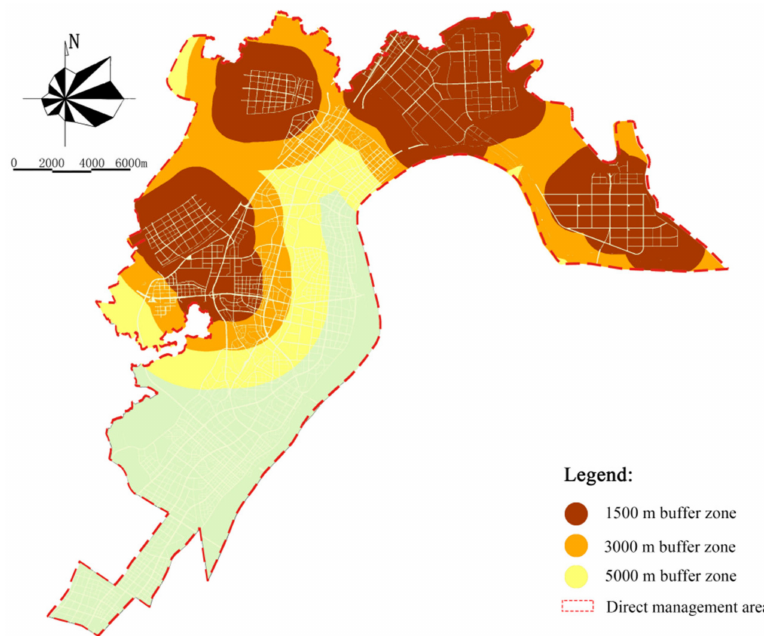
Figure 7. Multi-ring buffer zone analysis of industrial park.